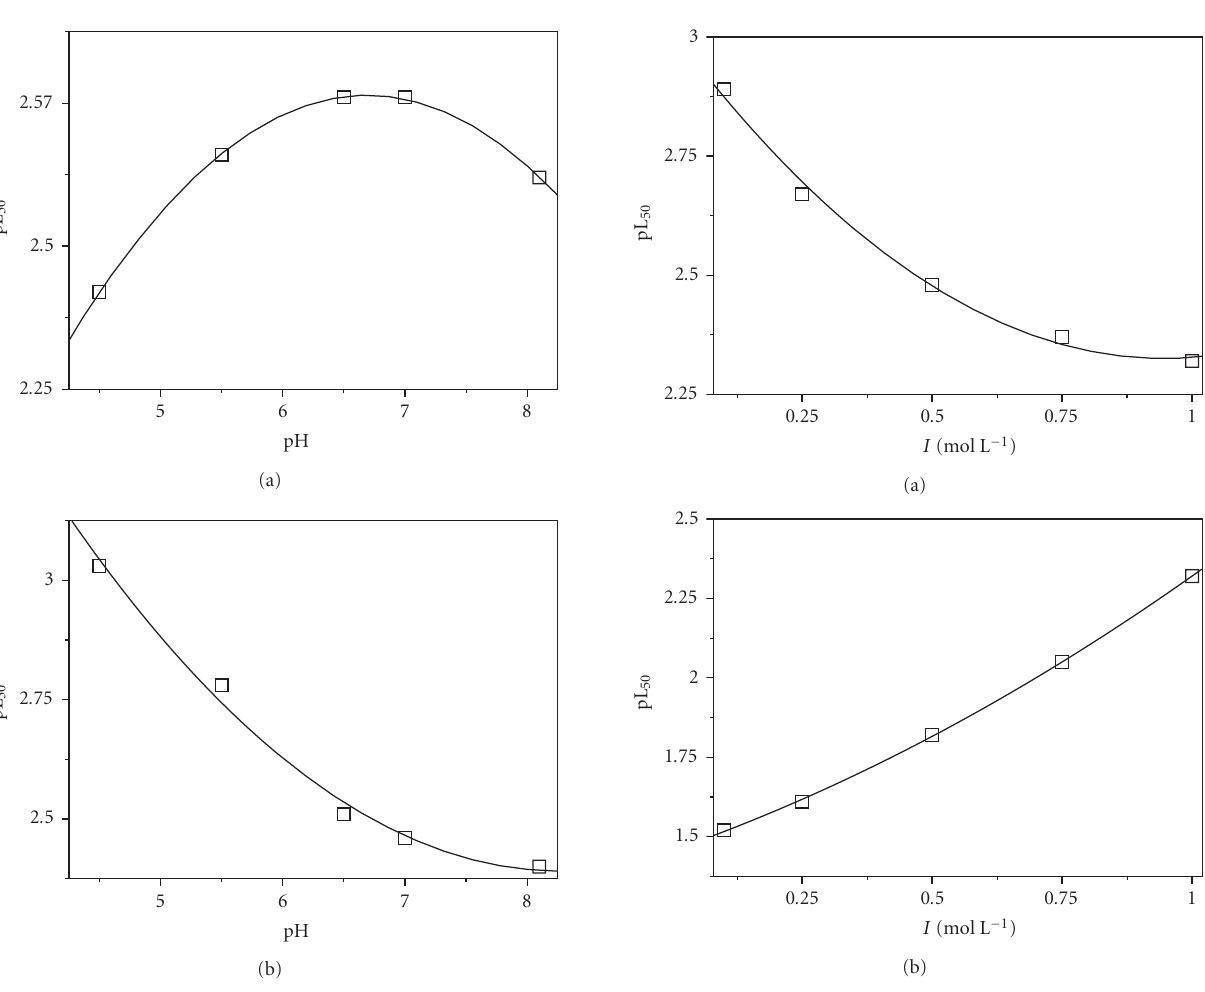
Figure 7: Dependence on ionic strength (in mol L − 1 ) of pL for dmt sequestration by paam (a) and asp (b) at pH = 6.5 and t = 25 ◦